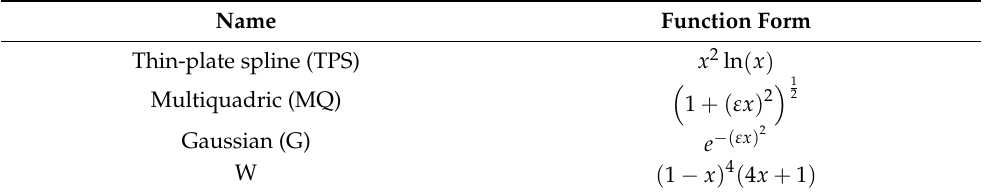
Table 1. Common basis functions.